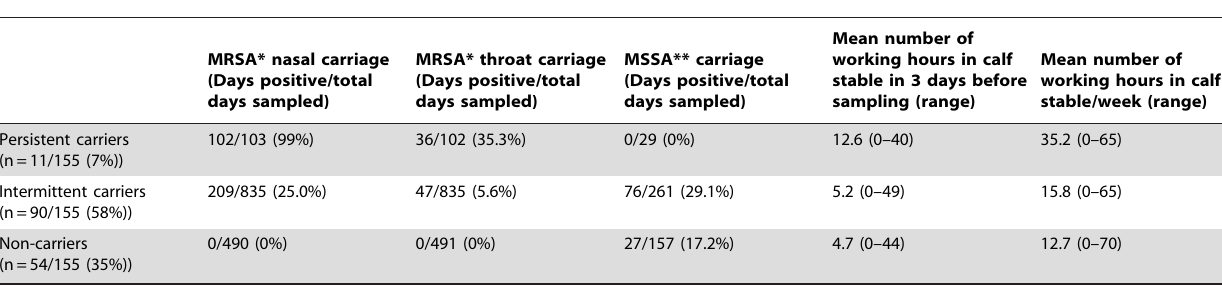
Table 5. Characteristics of persistent-, intermittent- and non-carriers of MRSA.